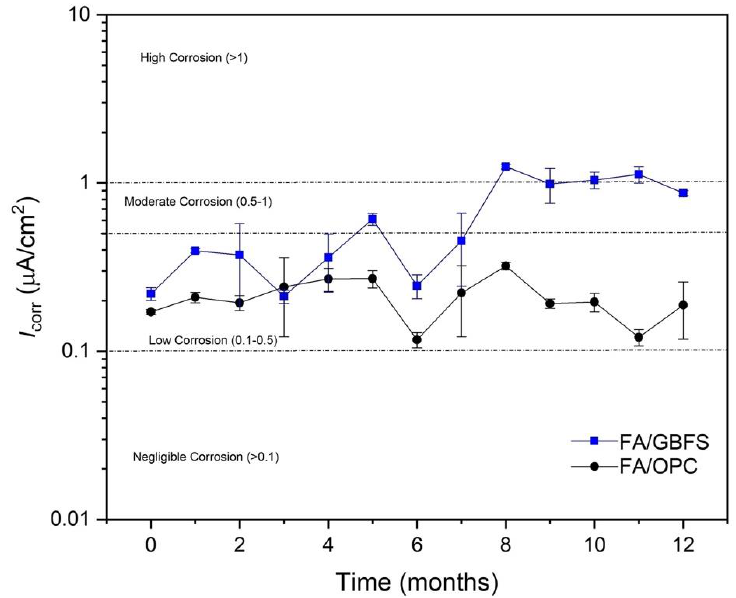
Figure 10. Current density (I corr ) of specimens exposed to drinking water.